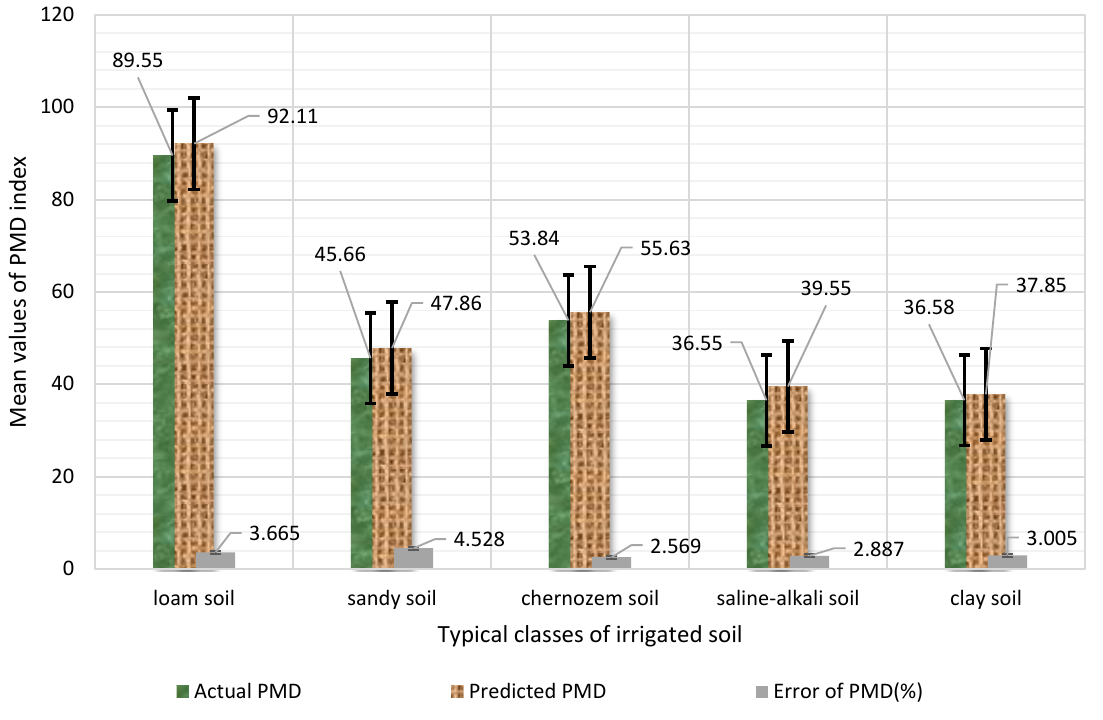
Figure 17. Comparison between the actual and predicted PMD values in typical soil types.